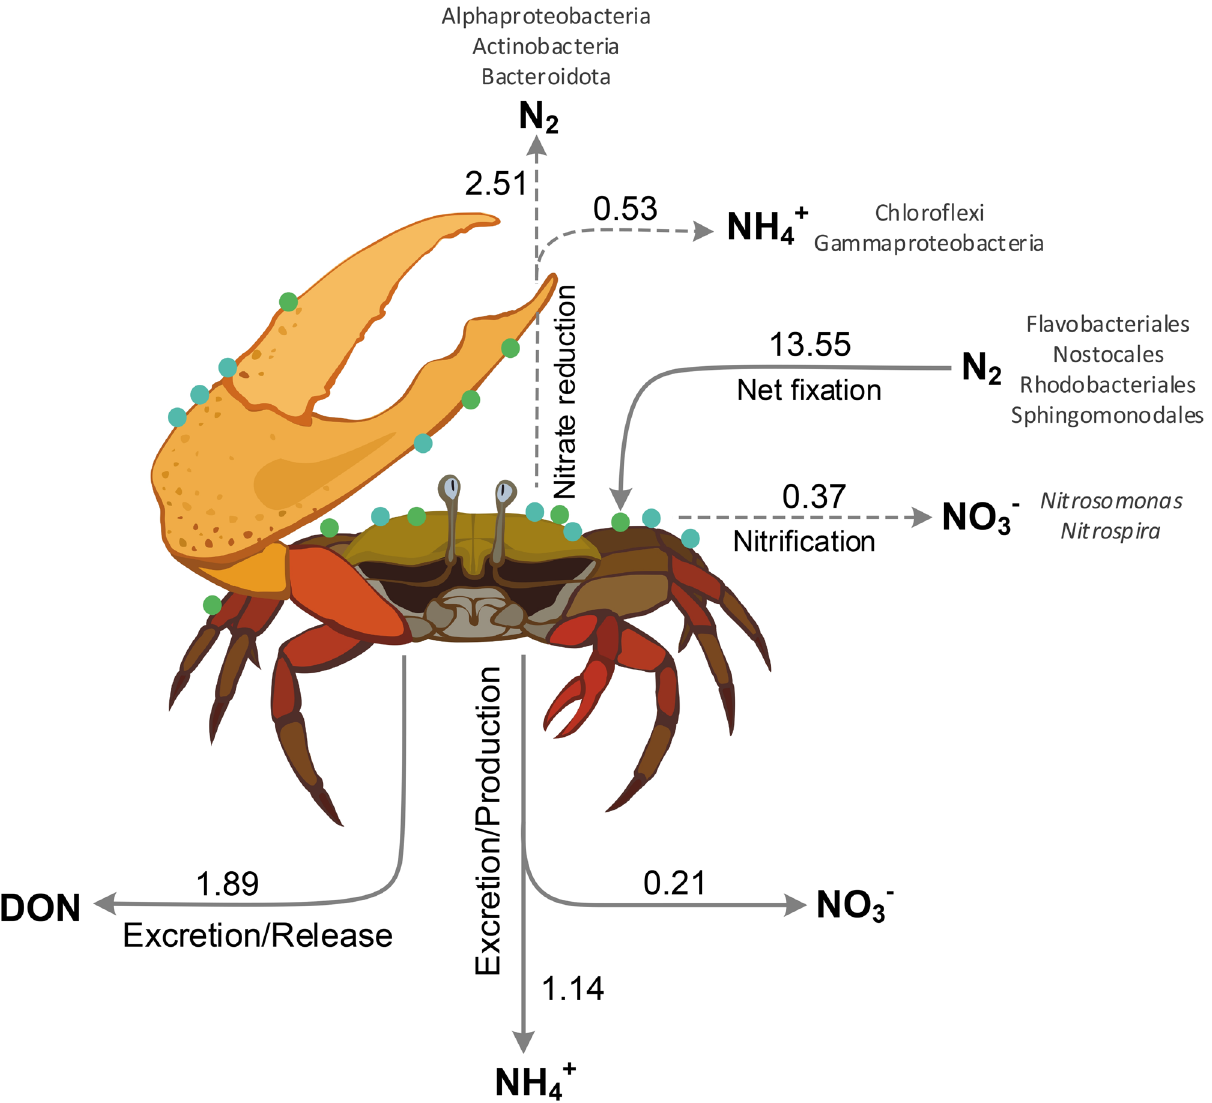
Figure 5. Flowchart of N-cycling by the fiddler crab holobiont: all fluxes were obtained combining data from incubations of single crab holobiont (in situ rates, solid lines) and suspended biofilm (potential rates, dashed lines). Note that reported rates differ from those in Table 2 as they were normalized per mean dry weight of crab’s biofilm or per mean dry weight of incubated fiddler crab and are expressed as µmol N crab −1 d −1 . The main taxonomic groups involved in N-cycling as indicated by metagenomics analyses are provided. Drawing by V.